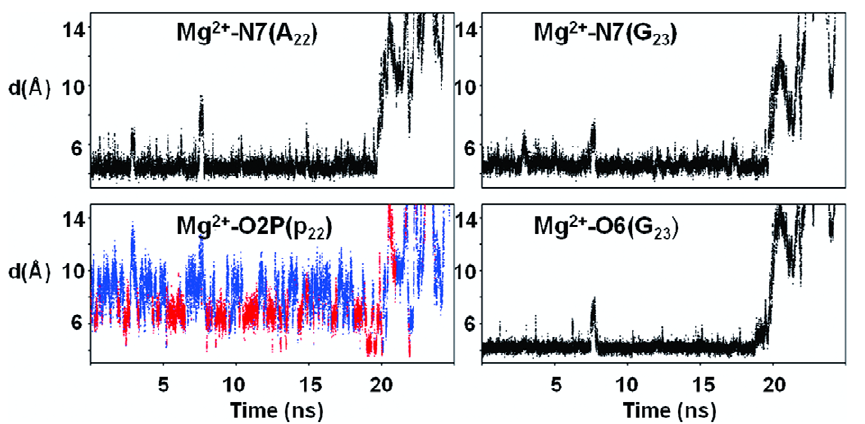
Figure 3. Distances characterizing the interaction between Mg 2 + and DNA during the MD simulations. The distances between Mg 2 + and the electronegative atoms N7(A 22 and G 23 ), O6(G 23 ) and O2P(p 22 ) belonging to the p 22 A 22 p 23 G 23 fragment were extracted from S1. Mg 2 + interacts with A 22 and G 23 via its first hydration shell for roughly 20 ns, as shown by the values of the distances d(Mg 2 + – N7(A 22 )), d(Mg 2 + – N7(G 23 )), and d(Mg 2 + – O6(G 23 )). O2P(p 22 ) is transitorily close to Mg 2 + . Short Mg 2 + – O2P(A 22 ) distances are associated with p 22 in BII (BI in blue, BII in red). Identical interaction patterns are observed in S2 and S3.